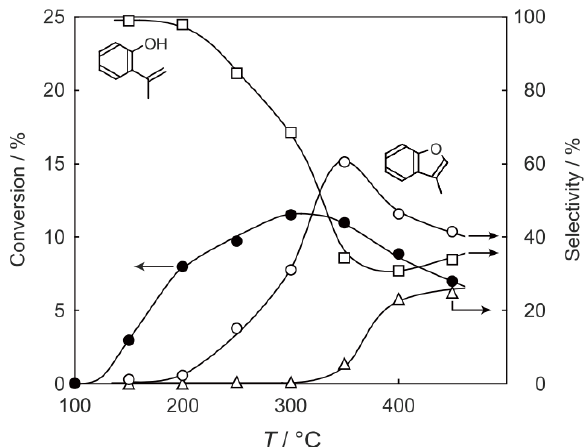
Figure 22. Effect of temperature on the reaction of phenol with acetone over [(Ta Cl )Cl (H O) ]·4H O/SiO . After activation of the supported cluster (100 6 12 2 2 4 2 2